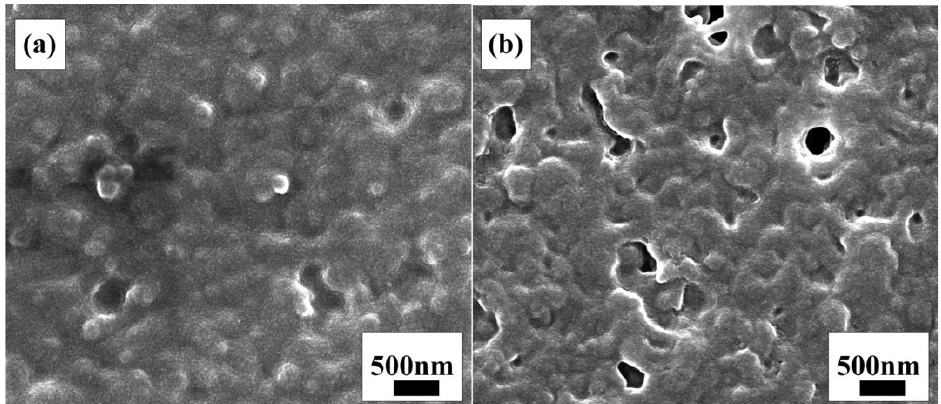
Figure 2. SEM images of the thin film at different stages: ( a ) TiO 2 gel thin film before UV light irradiation; ( b ) TiO 2 gel thin film after UV light irradiation.